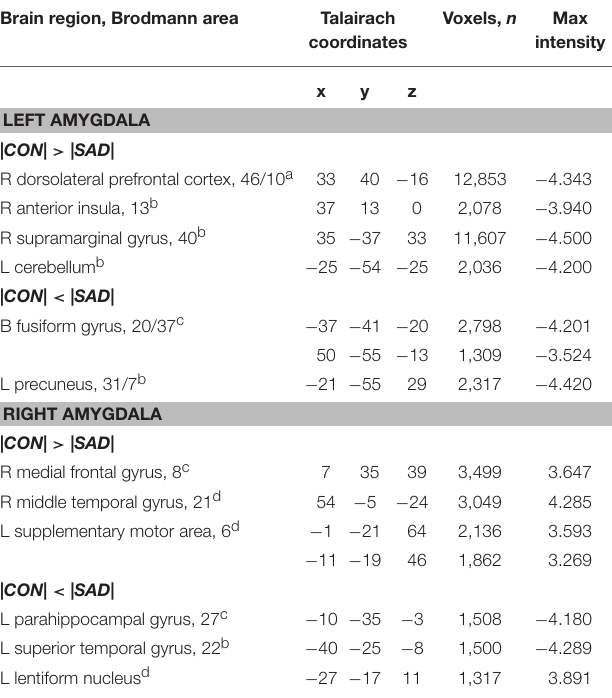
TABLE 2 | Group differences in the resting-state functional connectivity of the left and right amygdala. Brain region, Brodmann area Talairach